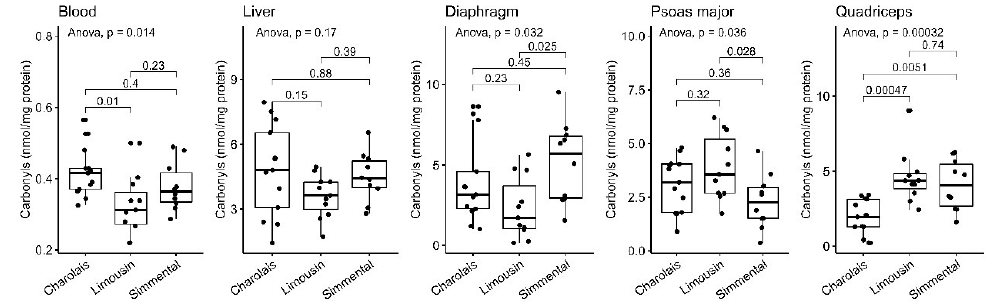
Figure 5. Protein carbonyls levels in the blood, liver, diaphragm, quadriceps and psoas major of CHA, LIM and SIM cattle.